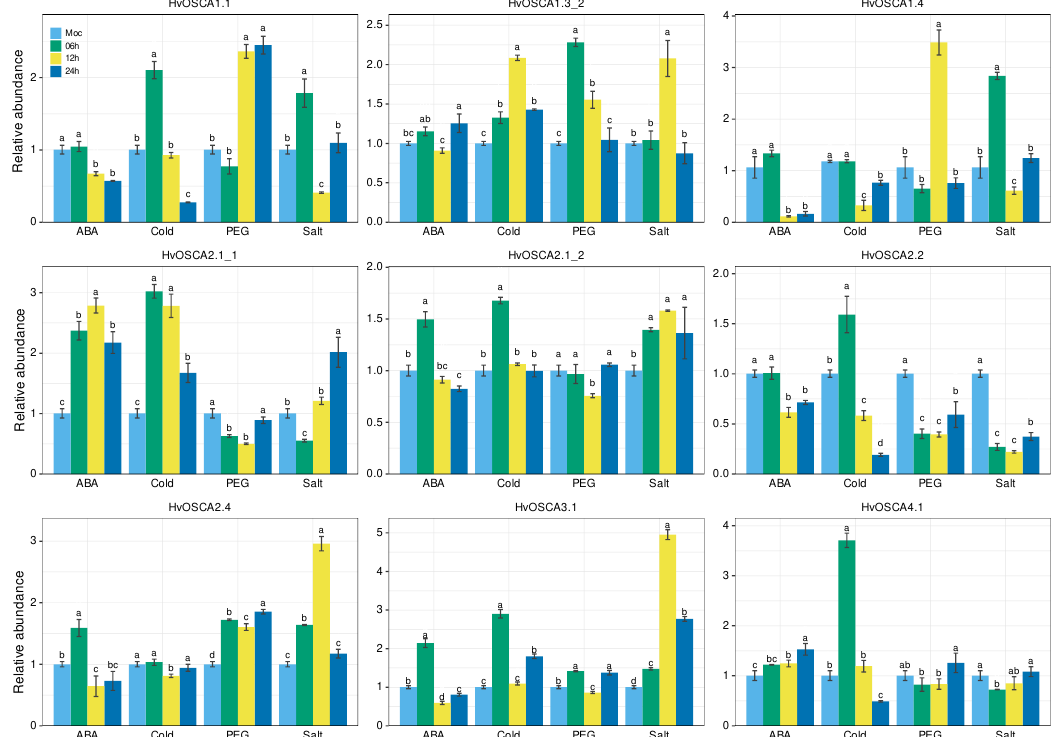
Figure 6. Validation of the expression signature of nine HvOSCA genes under ABA (100 µ M ABA), cold (4 ◦ C), drought (20% PEG-6000) and salt (NaCl) treatment through the qRT-PCR method. The treatments were conducted with 100 µ M ABA solution for ABA, 4 ◦ C for cold, 20% PEG 6000 solution for drought, and 150 mM NaCl solution for salt stresses, respectively. Data represent the average of three technical replications and the error bar represents the standard error of mean